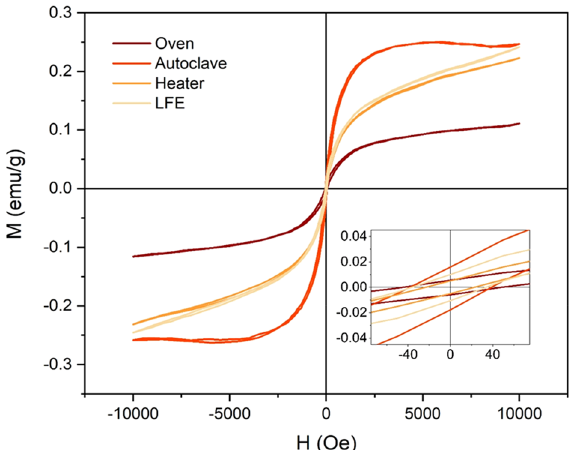
Figure 2. VSM diagram of FGPs to determine the contribution of temperature, pressure, and magnetic field in magnetism. The hysteresis loop of all samples and the zoom part of diagram − 90 < H < 90 (Oe) and − 0.045 < M < 0.045 (emu/g) in the